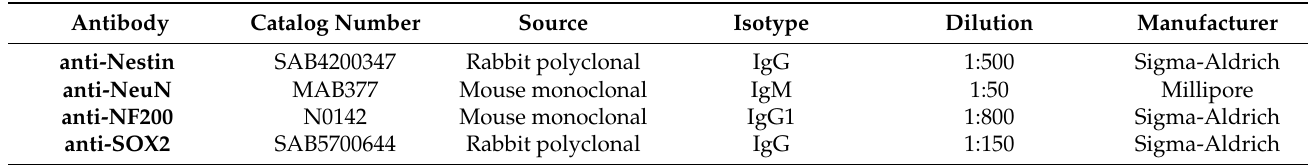
Table 2. Primary antibodies used for the experiments.